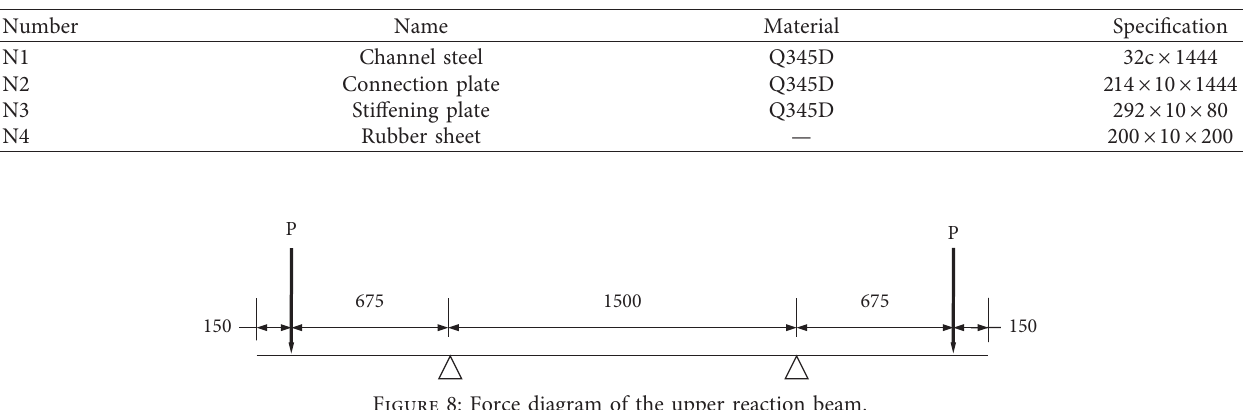
Figure 7: Cross section of lower reaction beam. Table 4: Materials used in the single reaction beam.